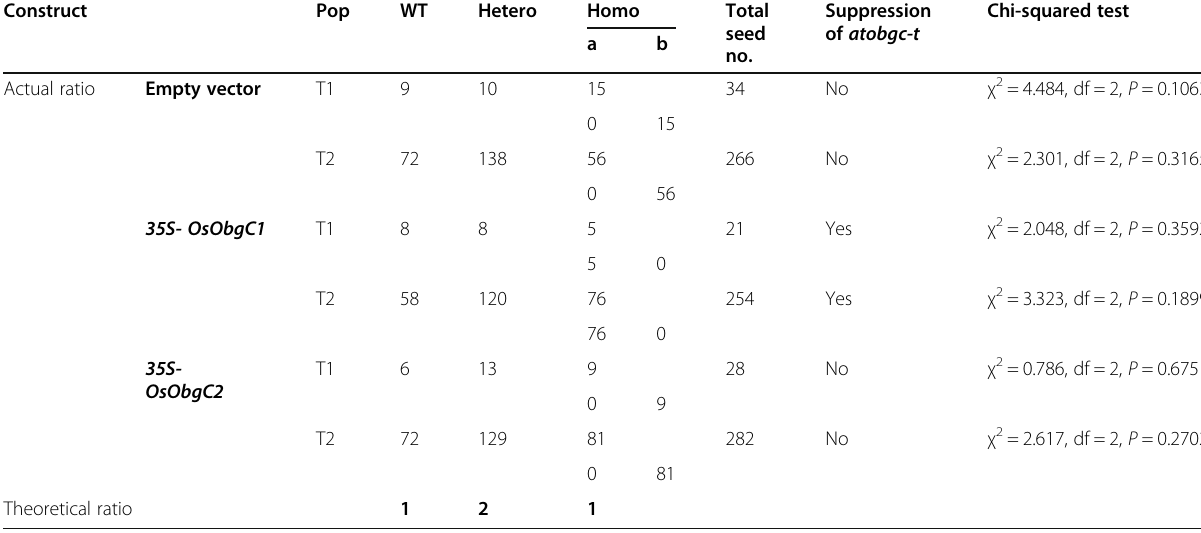
Table 1 Complementation analyses of Arabidopsis atobgc-t phenotype with rice ObgC homologs